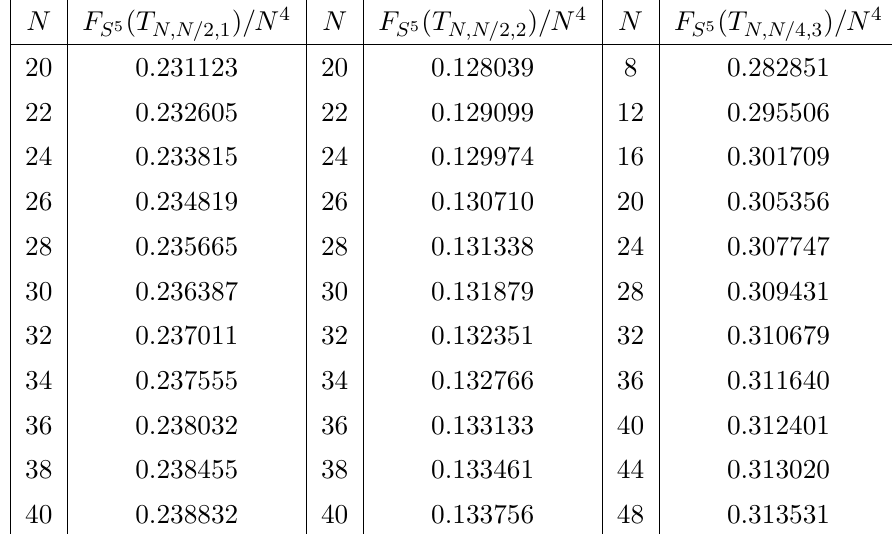
Table 1 . Numerical values for the saddle point evaluation of the (cid:12)ve-sphere free energy for T N;K;j